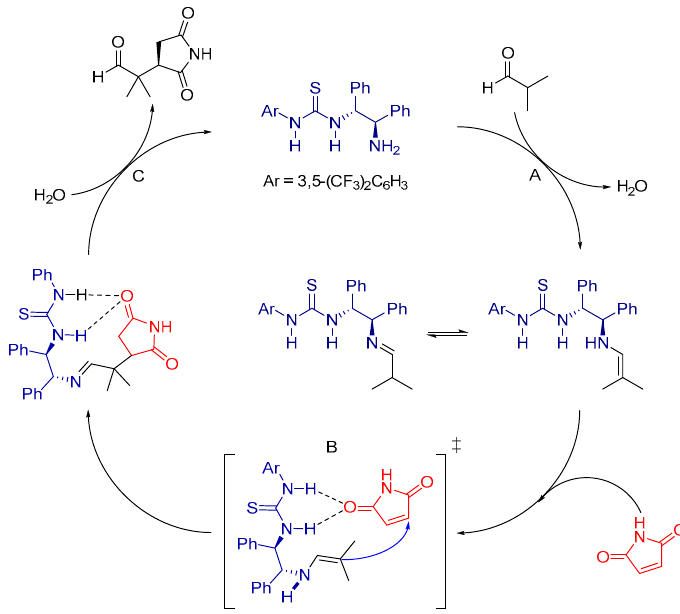
Figure 3. Catalytic cycle of the Michael reaction and proposed transition states.